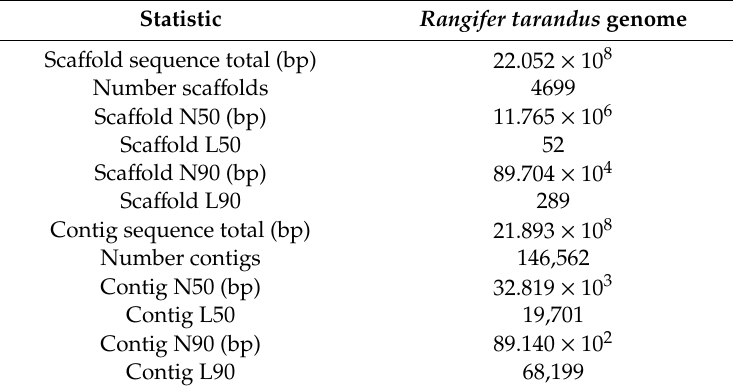
Table 1. Assembly statistics of the caribou genome.